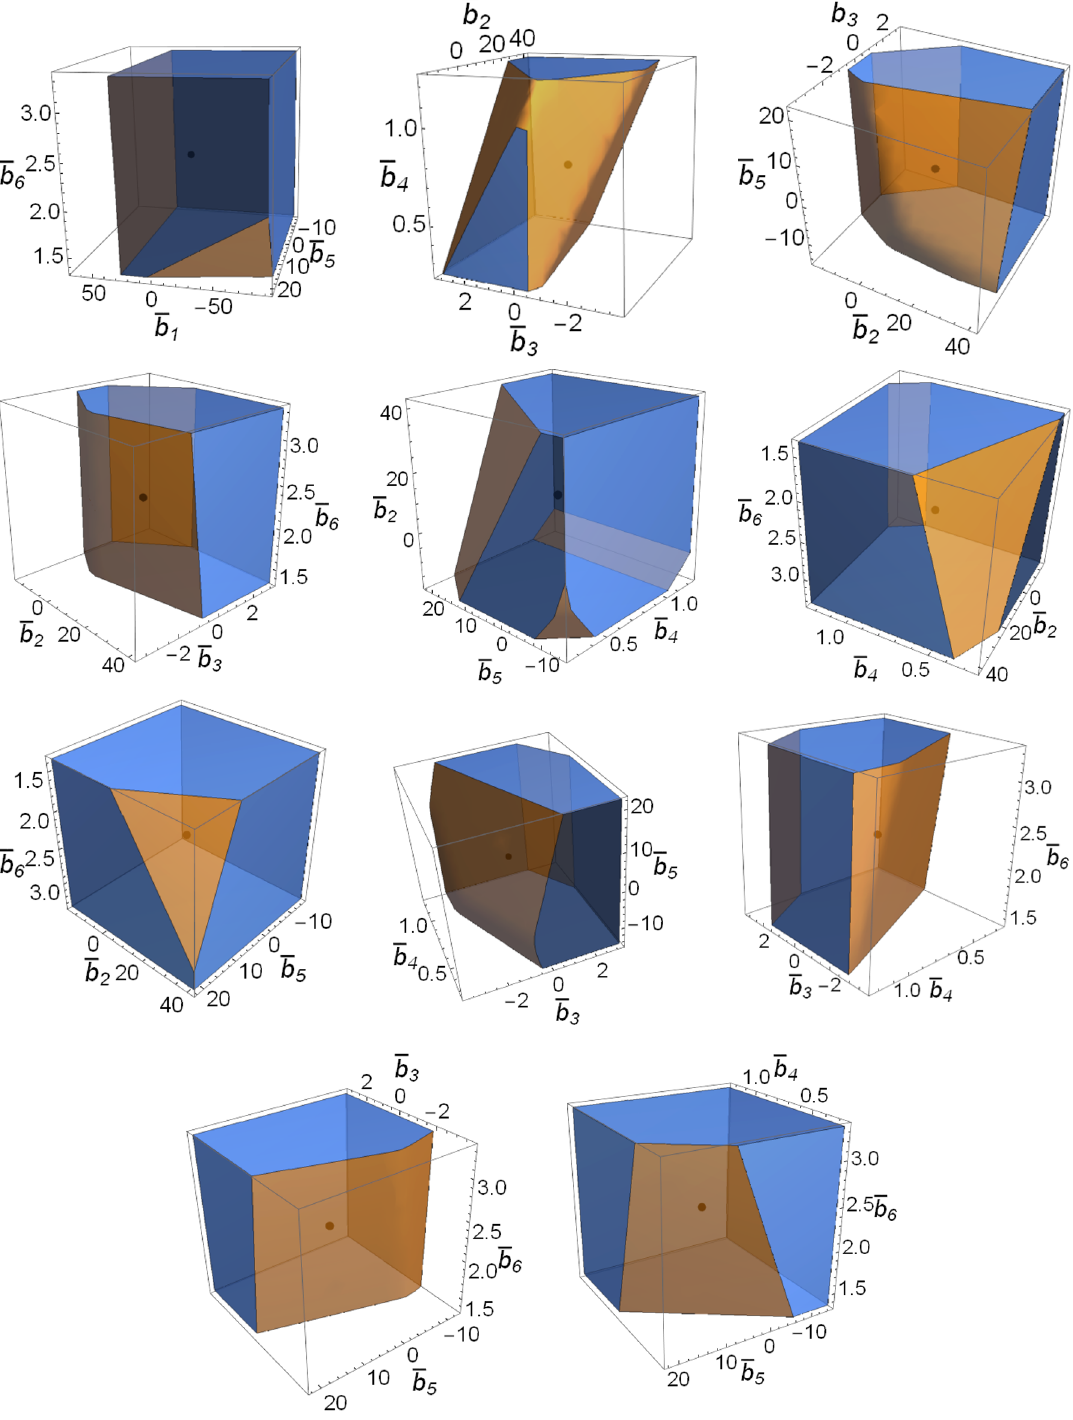
Figure 15 . Continuation of (cid:12)gure 14.